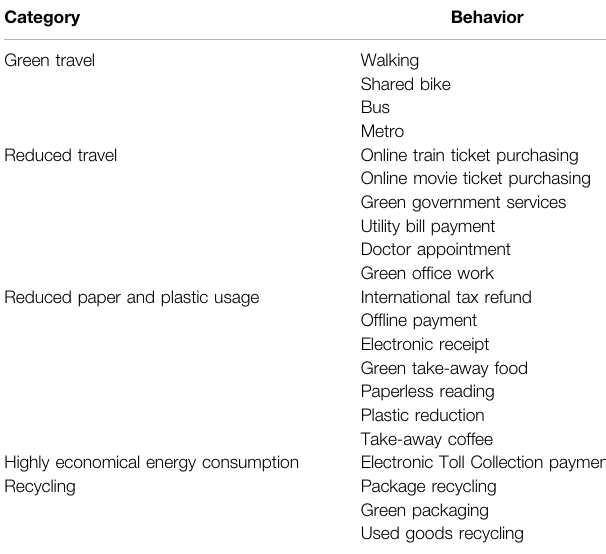
TABLE 10 | Opportunities for sustainability supported by Internet payment platforms.